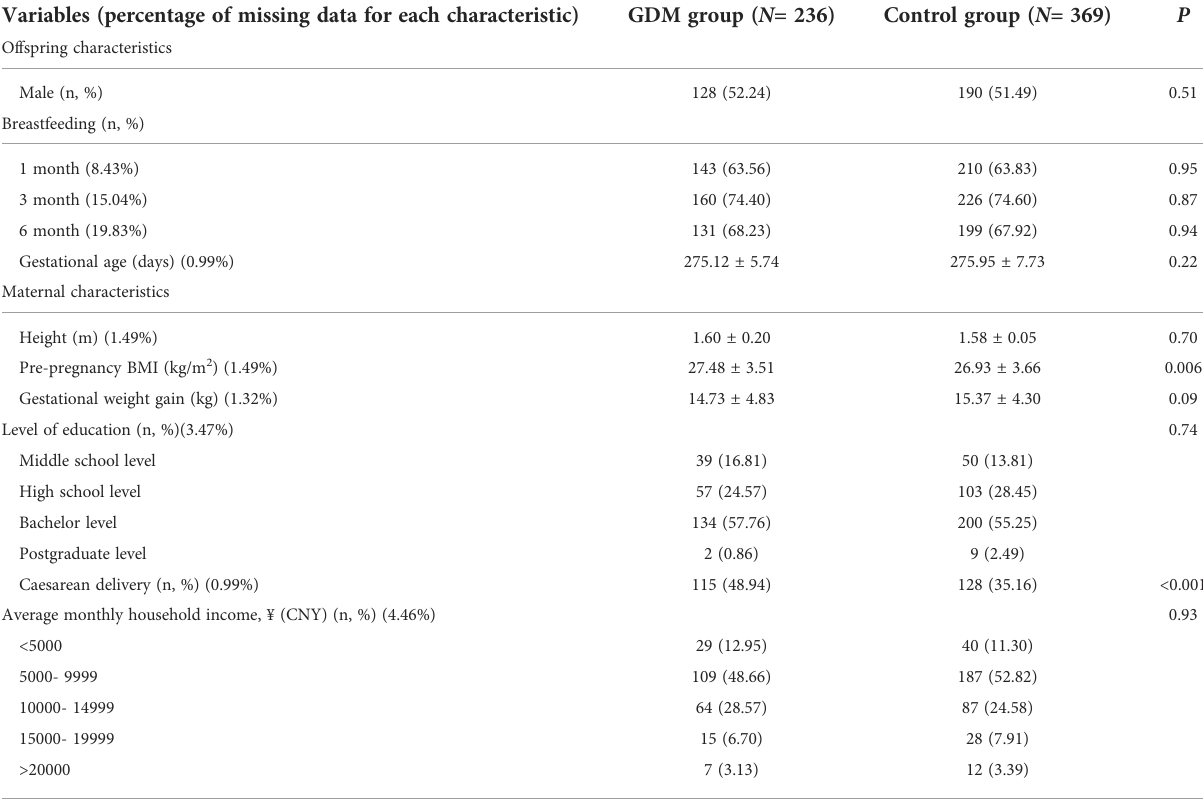
Values are mean ± SD, or n (%). GDM, gestational diabetes mellitus; BMI, body mass index. GDM group: offspring of mothers with well-controlled gestational diabetes mellitus without insulin. Control group: offspring of mothers without GDM (control group). Statistical signi fi cance was set at P < between offspring in the GDM group and control group (Table 2). The trajectories of Z-scores for WAZ, LAZ, and BMIZ, using the mean ± SEM values reported in Table 3, are plotted for the period of 0-12 months of age in Figure 2 for both groups. The trajectories for WAZ, LAZ, and BMIZ were not different between the GDM and control group over the period of 0-4 months, with a signi fi cant deviation for the GDM group, from the control group, becoming apparent after 4 months of age. As shown in Figure 2, the Z-score for all three variables, WAZ, LAZ, and BMIZ, were lower for the GDM than control